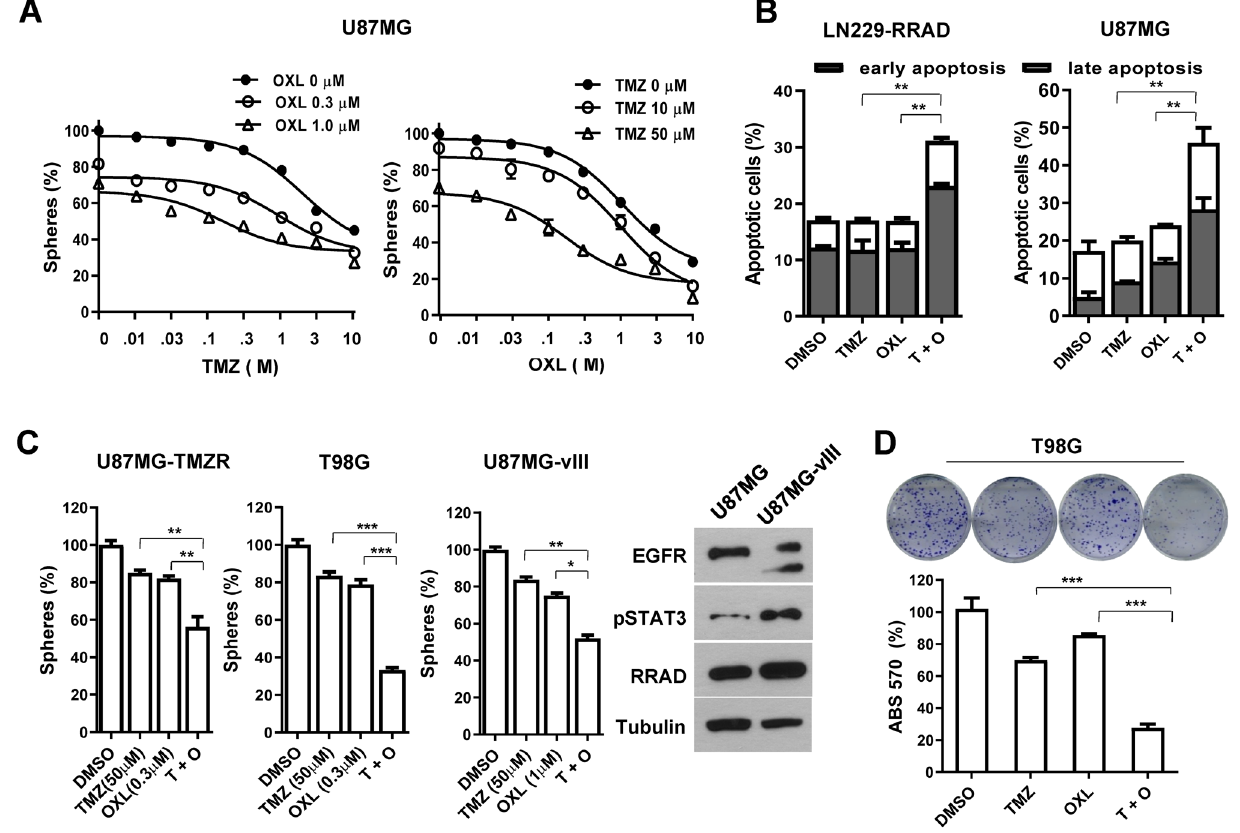
Figure 5. Combination effect of TMZ and OXL on growth and chemoresponse of glioblastoma cell lines. ( A ) Dose–response curves of TMZ in combination with different concentrations of OXL (0, 0.3, 1 μM) for U87MG cells (left) and dose–response curves of OXL in combination with different concentrations of TMZ (0, 10, 50 μM) for U87MG cells (right). ( B ) LN229-RRAD and U87MG tumorspheres were cultured in the presence of TMZ (50 μM), oxelaidin (0.1 μM) or TMZ plus oxelaidin for 2 days. Cells were harvested after 48 h, stained with Annexin V/PI and analyzed via flow cytometry. (** P ≤ 0.01). ( C ) U87MG-TMZ-resistant (U87MG- TMZR), T98G (MGMT-high) and U87MG vIII (constitutively active EGFR) tumorspheres were cultured in the presence of TMZ, OXL or TMZ plus OXL for 7 days and the number of tumorspheres counted. ( D ) T98G cells were treated with 300 μM TMZ, 10 μM OXL or TMZ plus OXL. The clonogenic assay was performed after 2 weeks of treatment. All data represent mean ± S.D of experiments performed in triplicate. (* P ≤ 0.05; ** P ≤ 0.01; *** P ≤